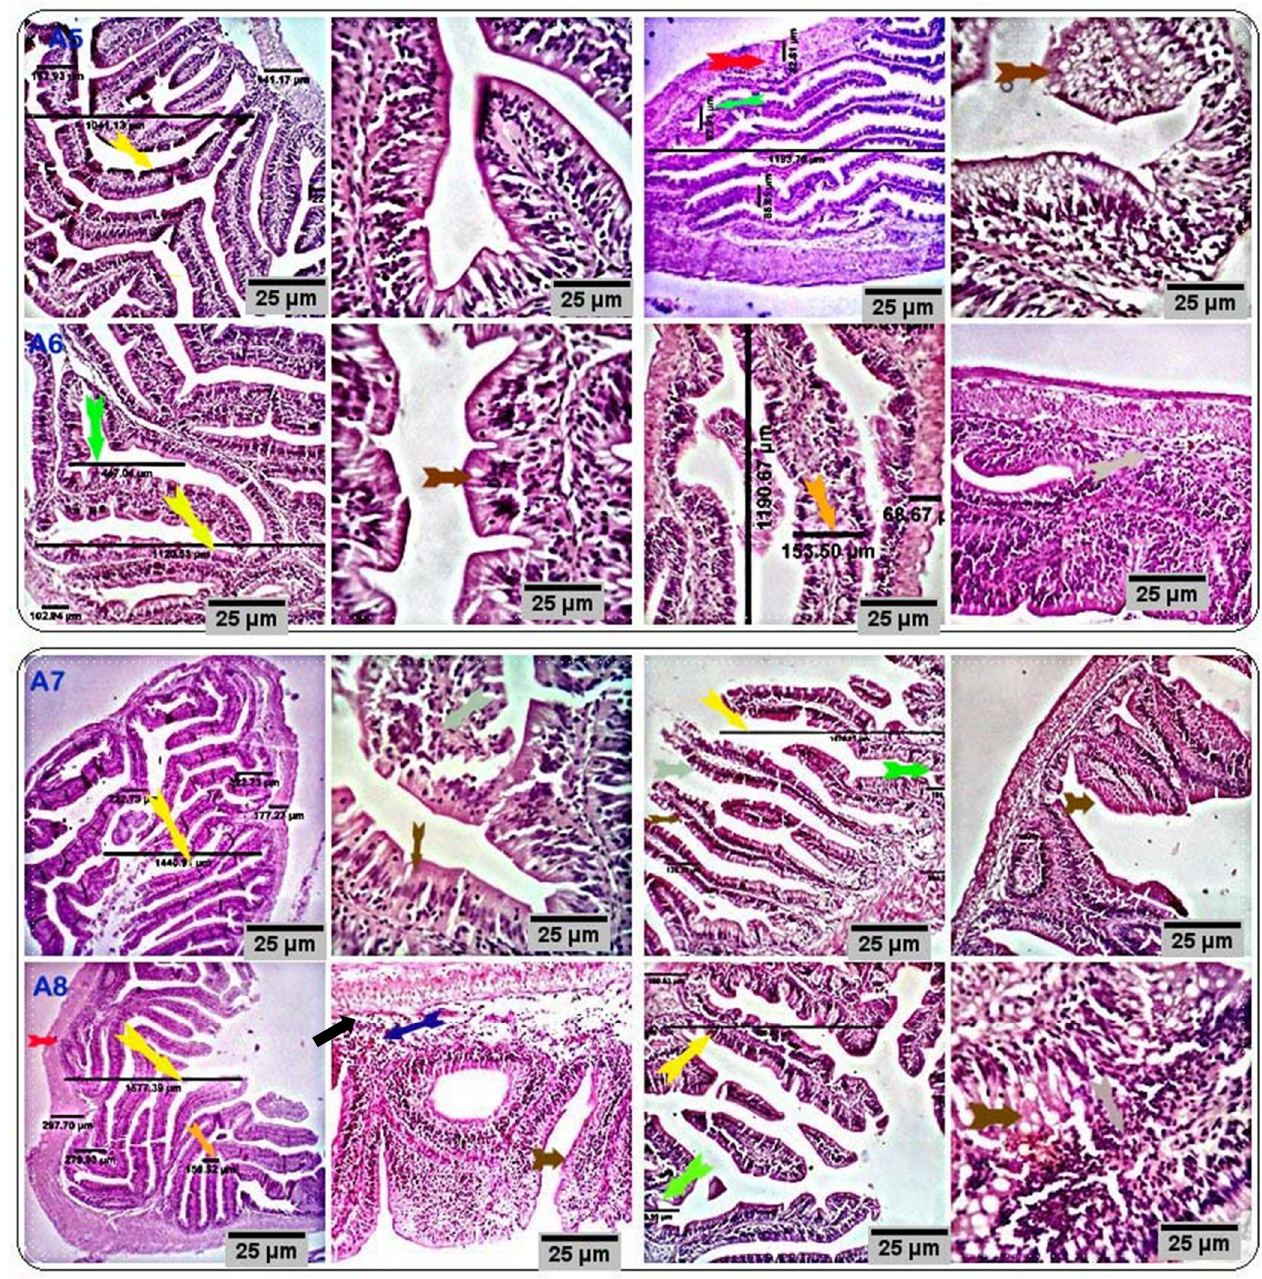
Figure 3. Stained sections of the anterior and posterior intestines of the respective treatment groups (CUR200, CUR400, CUR600, and CUR800) showed normal histomorphological structures with an increase in the villus height and crypt depth (yellow and green arrows), goblet cell number (brown arrows), and the number of mucosal and submucosal immune cells (black arrows). A moderate number of eosinophilic granular cells are seen in the submucosal tissue of all experimental groups, particularly groups CUR400 and CUR600 (blue arrow). Scale bars = 25 µm. (A5: CUR200, A6: CUR400, A7: CUR600, and A8: CUR800).